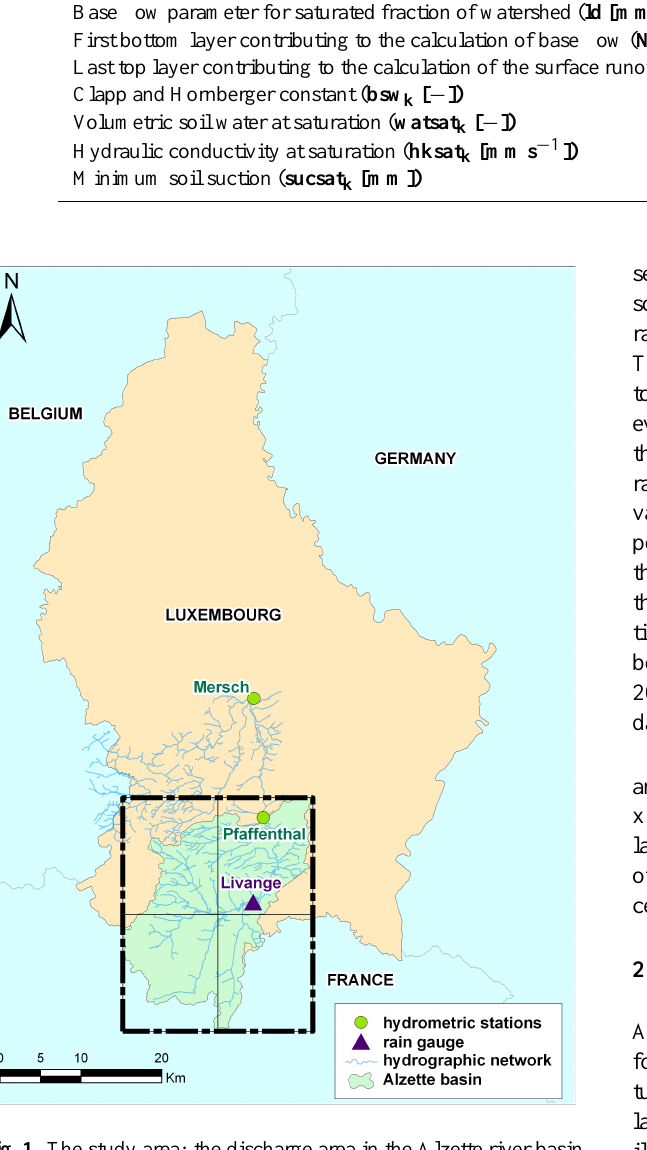
Fig. 1. The study area: the discharge area in the Alzette river basin is indicated by the green